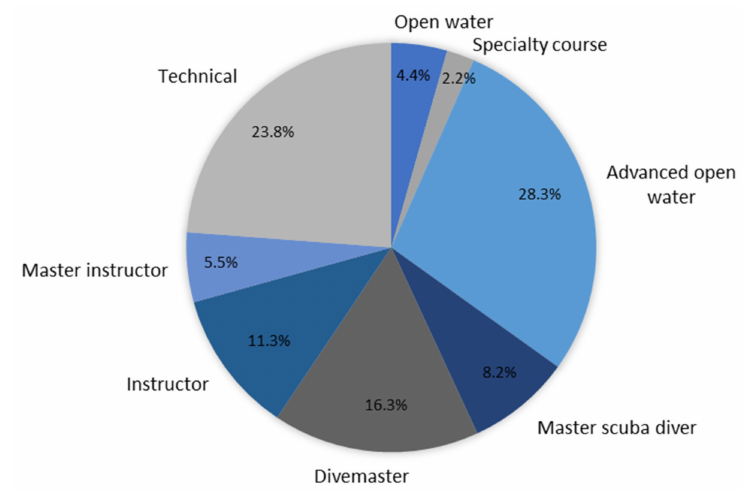
Figure 3. Highest level of dive